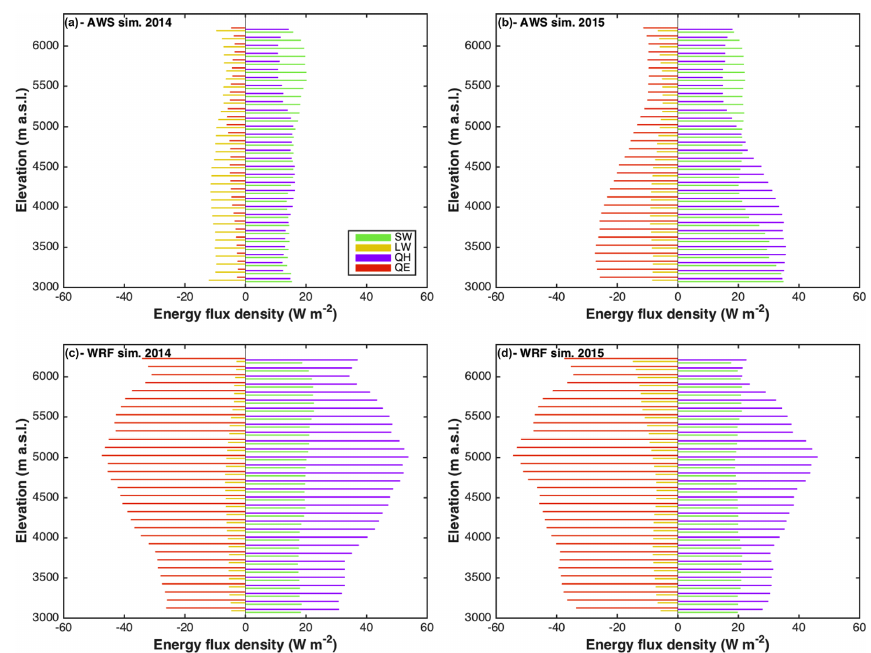
Figure 9. Annual mean of main modeled energy fluxes (computed over snow surfaces only) for each 200m elevation band using AWS (a, b) and WRF (c, d) forcing for 2014 (a, c) and 2015 (b, d) . SW is net shortwave radiation, LW is net longwave radiation, QE is the latent heat flux and QH is the sensible heat